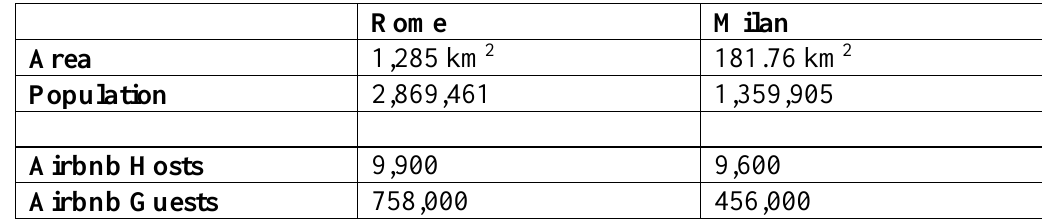
Figure 4: Airbnb Hosts and Guests in Rome and Milan, 2016 Rome